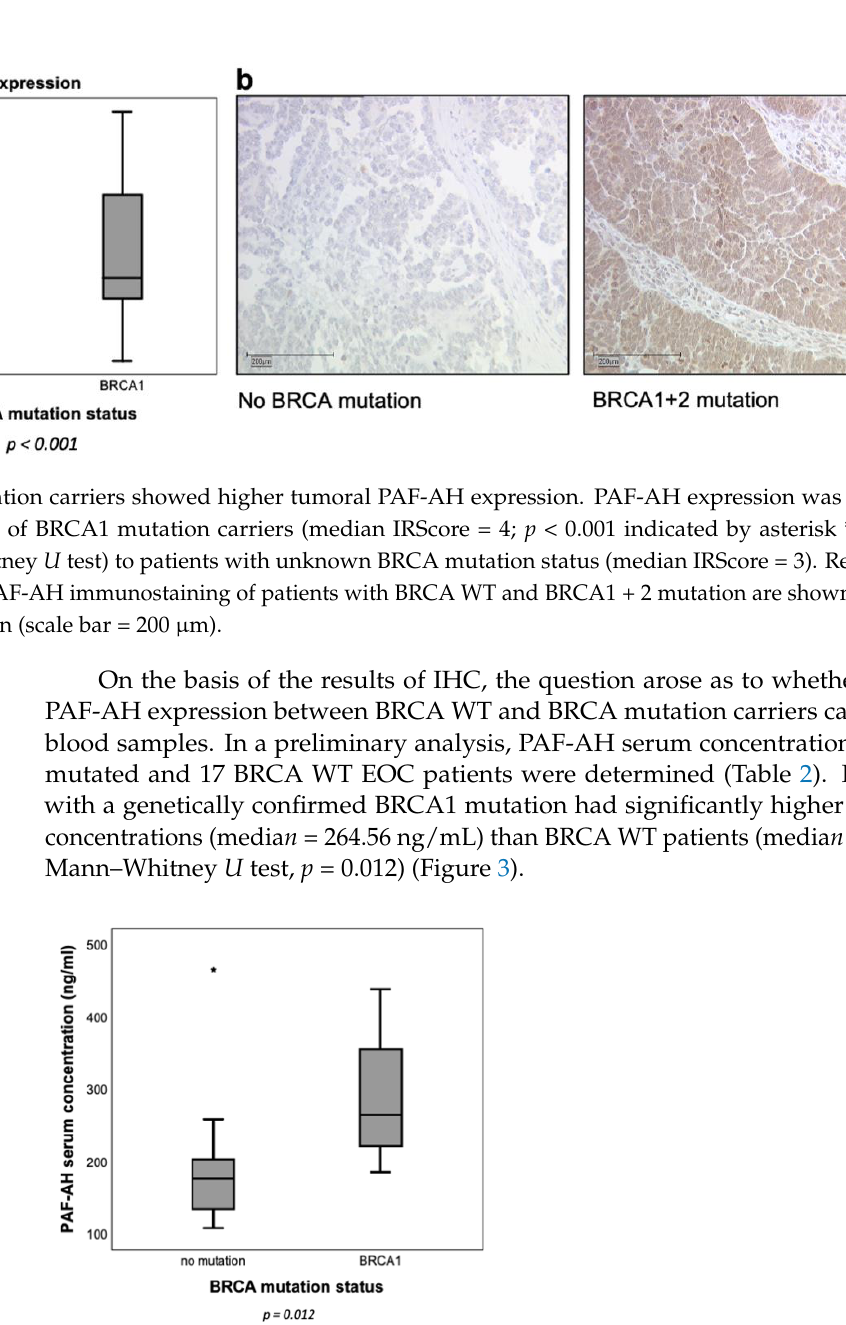
samples of BRCA1 mutation carriers ( n = 6) when compared to patients with BRCA WT ( n = 17) (Mann–Whitney U test, p = 0.012 indicated by asterisk